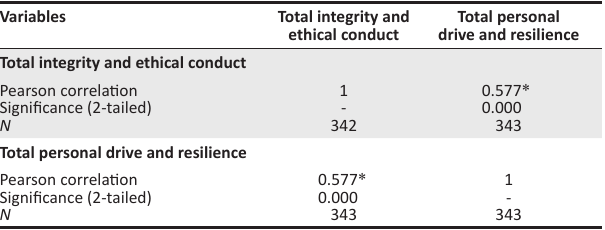
TABLE 6: Pearson correlation coefficients – Integrity and ethical conduct as well as personal drive and